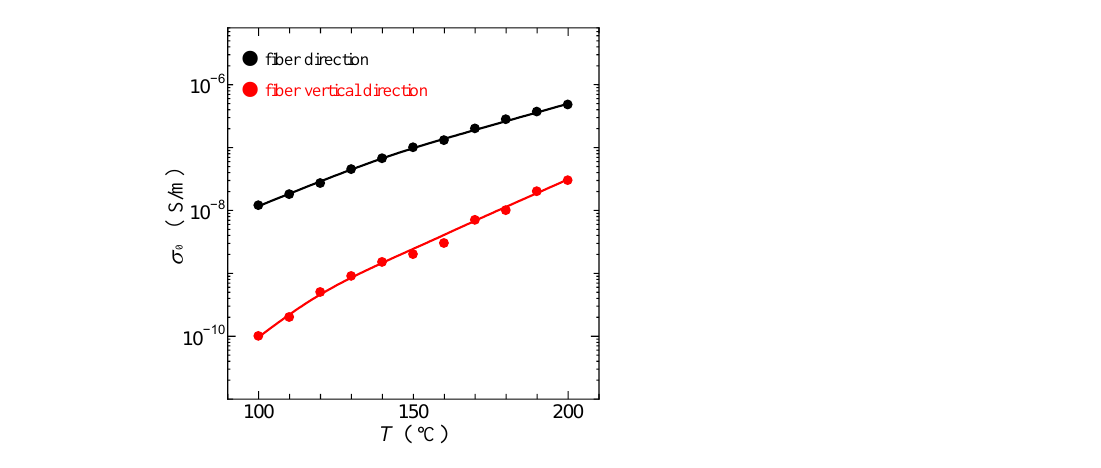
Figure 11. Relationship between fiber direction and conductivity of the HAp-collagen composite film.